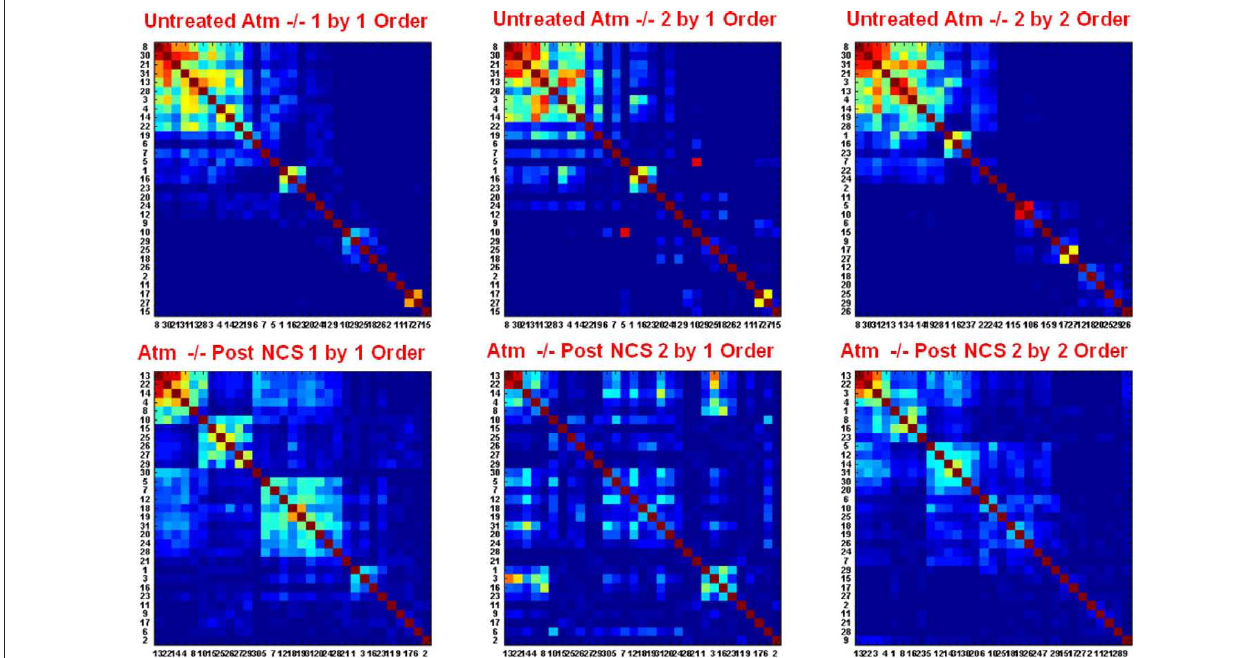
Figure 11 | Closer inspection breakdown of the phase synchronization persistence of the Atm − / − networks post NCS treatments. The results of the untreated cultures are shown at the top and the ones for post NCS treatments are shown at the bottom. For both cases we show the 15-min time window synchronization matrices for two consecutive time windows of 15 min. The matrices termed “1 and 2 by 2 order” refer to the independently ordered first (1) and successive (2) synchronization matrices using the dendrogram clustering algorithm. The matrices termed “2 by 1 order” mean to the second synchronization matrix presented using the dendrogram order of the first matrix (1). Visual inspection of the results clearly illustrates the breakdown of the synchronization persistence of the Atm − / − network post NCS treatment as is reflected by the significant differences between the structures of the “2 by 1